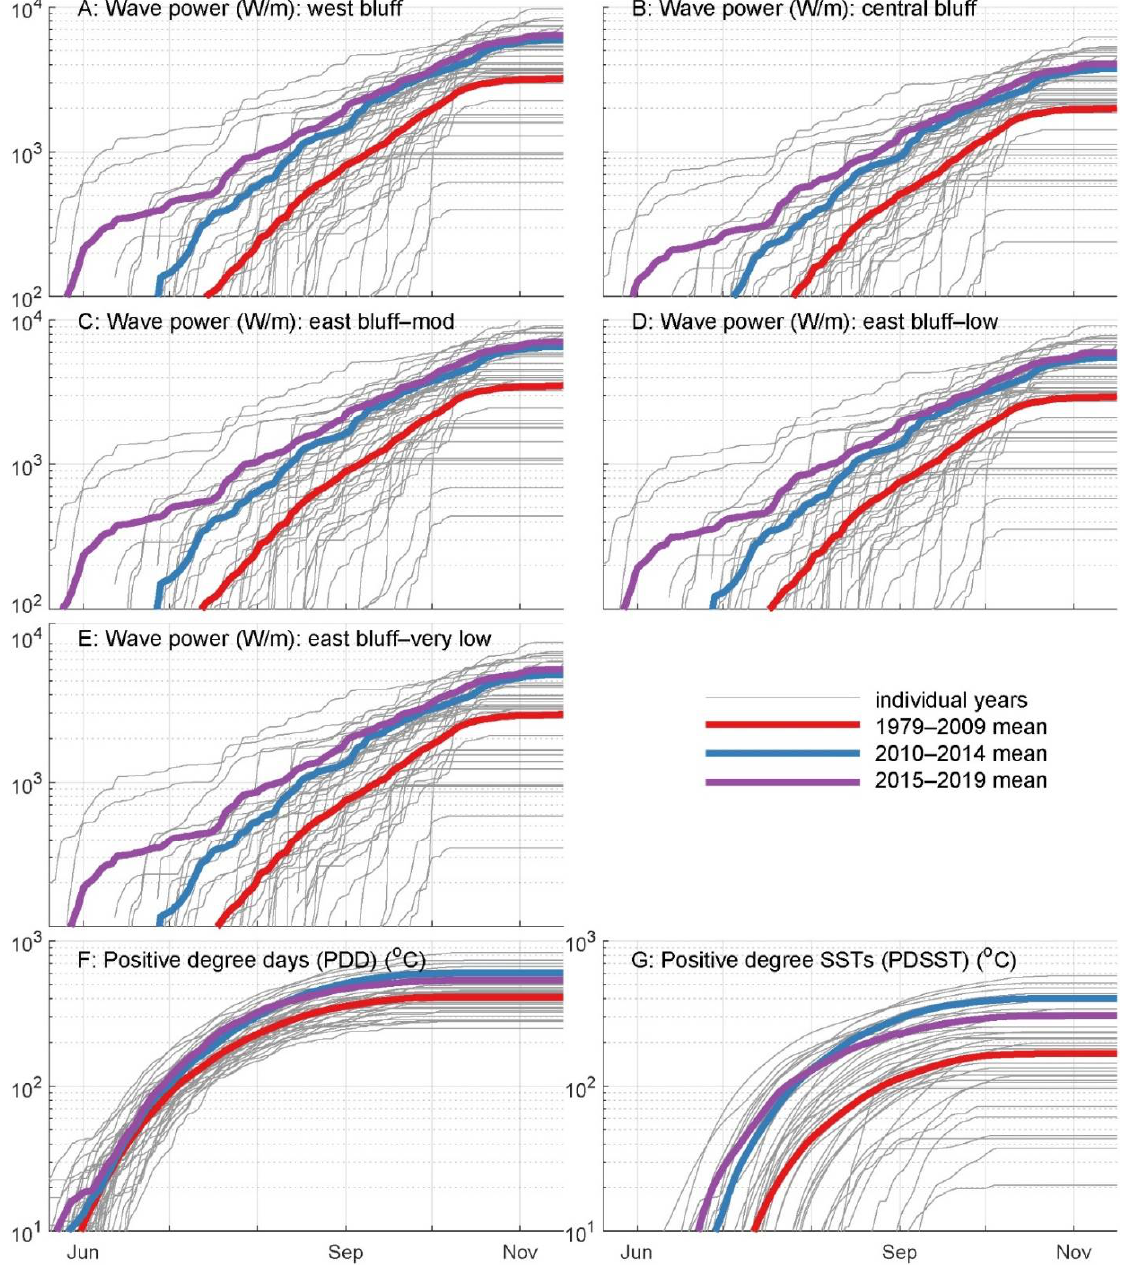
Figure 11. Annual cumulative sums of inshore wave power, positive degree days (PDD), and positive degree sea surface temperatures (PDSST). Solid lines show the mean annual cumulative sums calculated over the 30 year reference time period 1979–2009 and subsequent 5 year time slices from 2010 through 2014 and 2015 through 2019.